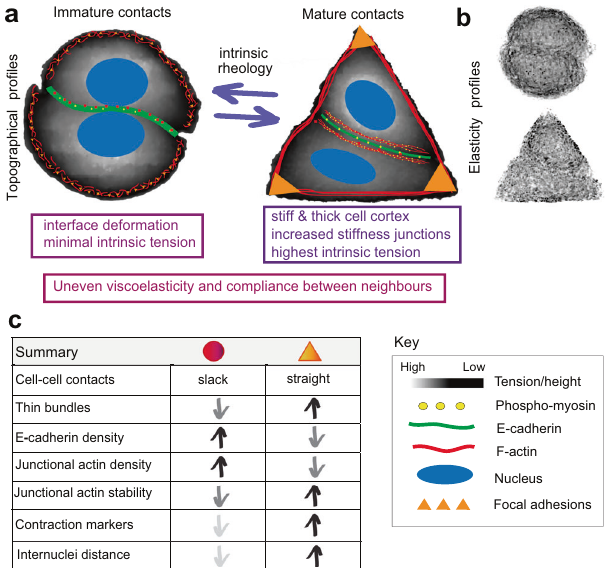
Fig.9|Intrinsiccellrheologydrivesjunctionmaturation — summary.a Diagram depicting the topographicalmaps ofcircular and triangular cell pairsingrey scale, representingheightasshorter(darkgrey)versushigherlengthvalues(white)ofcell pairs. Representation ofjunctions under different tensilestresses are shown asthe shape of cell-cell contacts (E-cadherin, green), organization of actin fi laments (red) at junctions and periphery of micropatterns as: lamellae (circles) or stress fi bres (triangles), focal adhesions (orange colour) and labelling of PMLC (yellow dots).